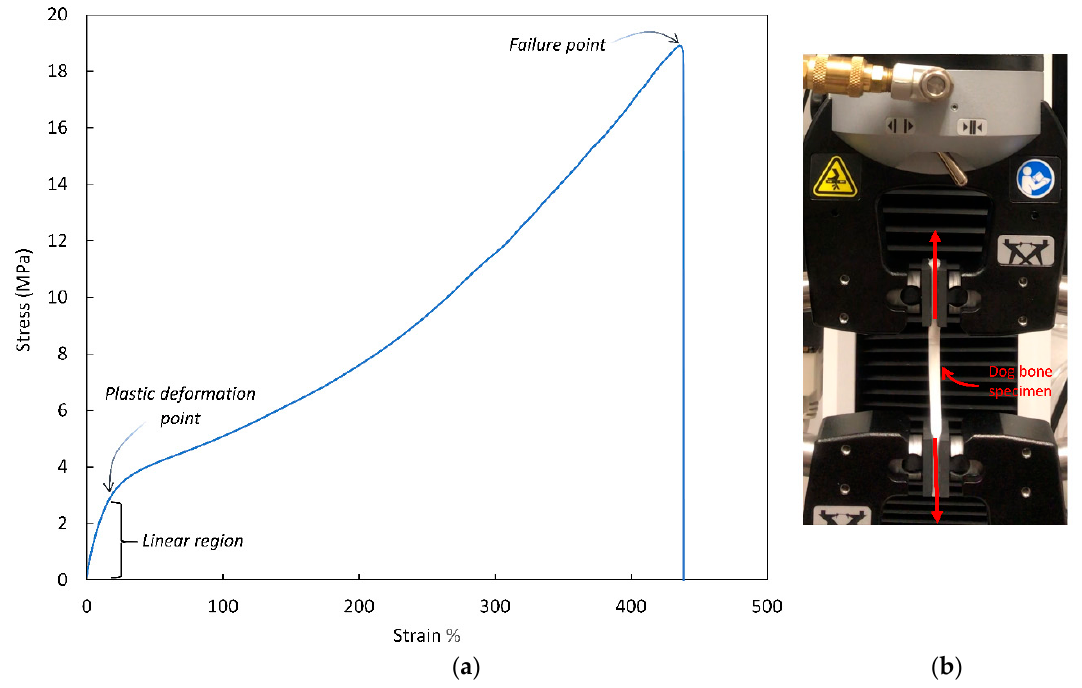
Figure 3. ( a ) Experimental tensile test of a TPU dog bone specimen, ( b ) Instron 3343 tensile testing machine setup.